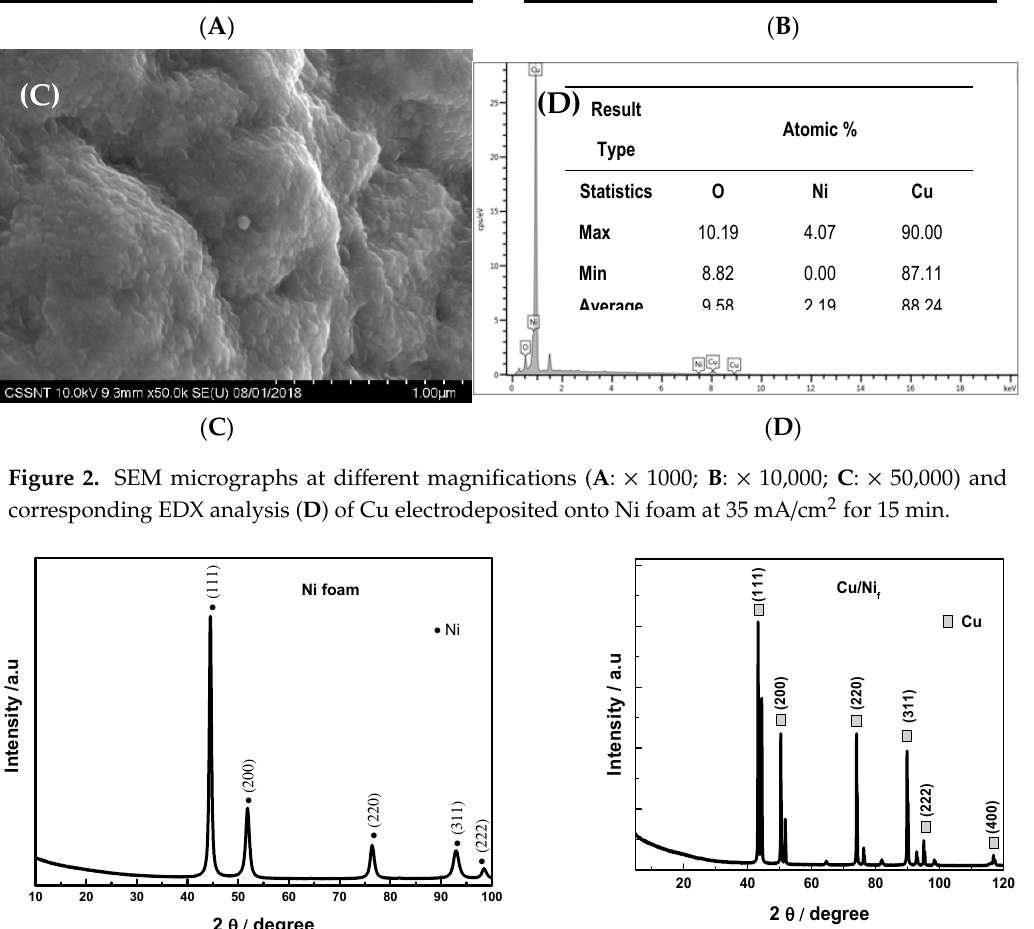
Figure 2. SEM micrographs at different magnifications ( A : x 1000; B : x 10,000; C : x 50,000) and corresponding EDX analysis ( D ) of Cu electrodeposited onto Ni foam at 35 mA/cm 2 for 15 min.